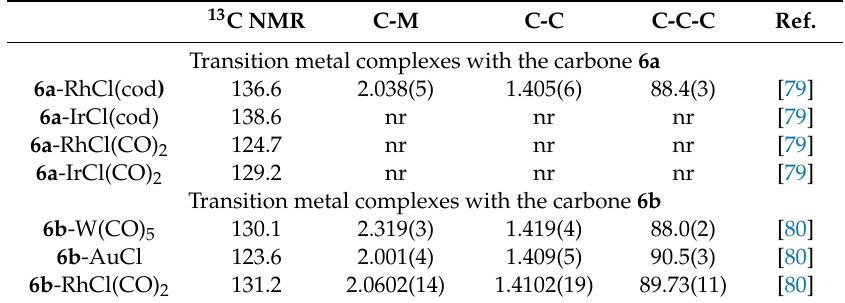
Table 6. Transition metal complexes with the all carbon ligand 6 ; 13 C NMR shifts (in ppm) of the donating carbon atom. Distances in Å, angles in